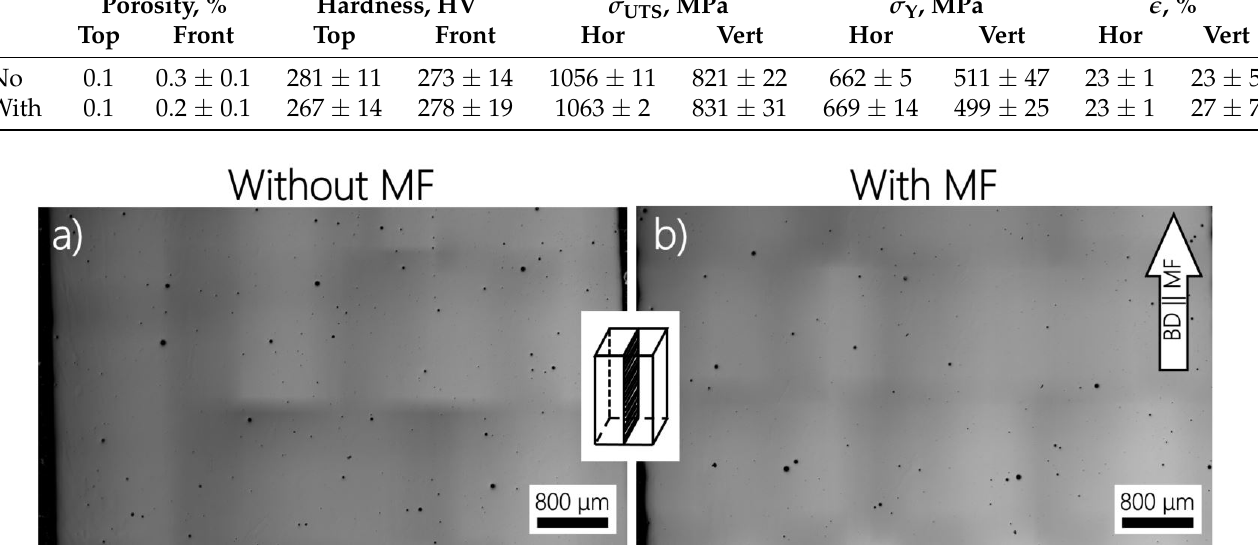
Figure 11. The porosity of AM Inconel 718 samples under no ( a ) and superimposed ( b ) vertical MF. The estimated pore sizes are as follows: ( a ) 36 ± 16 µm and ( b ) 41 ± 24